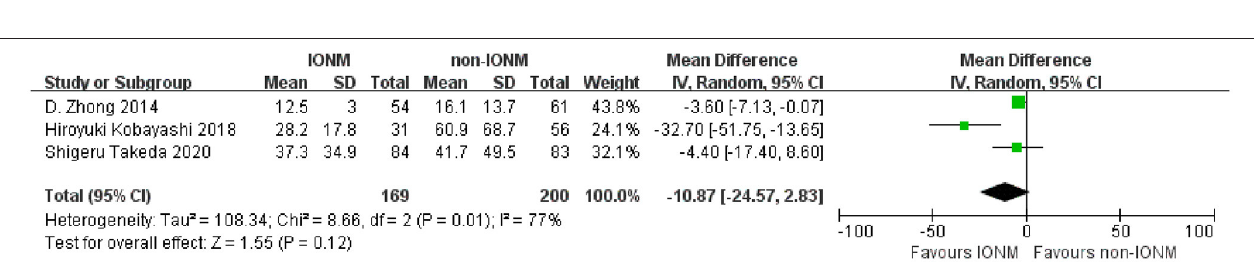
FIGURE 6 | Forest plot of length of hospital stay in the IONM and non-IONM groups.